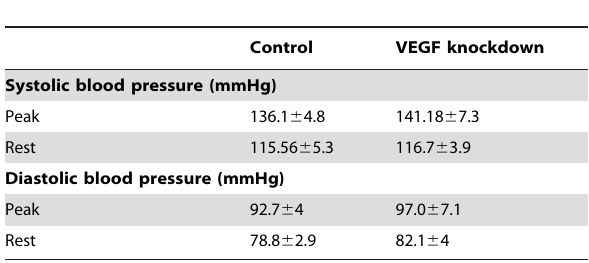
Table 2. Blood Pressure in siVEGF